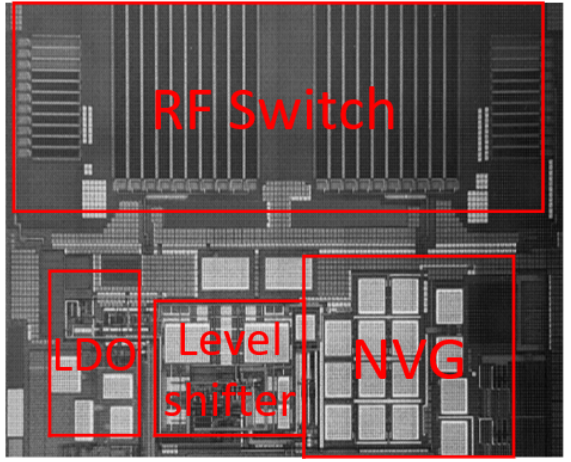
Figure 15. Photo of the fabricated